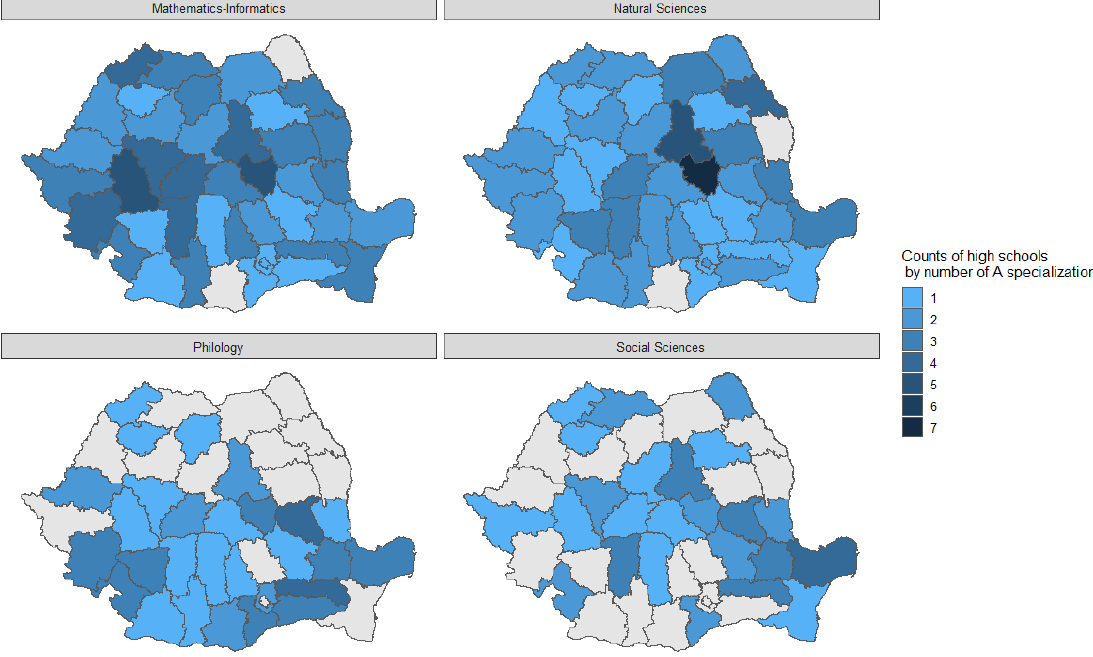
Figure 3. Counts of high schools by last admission rank-letter grade classification that have at least one A grade